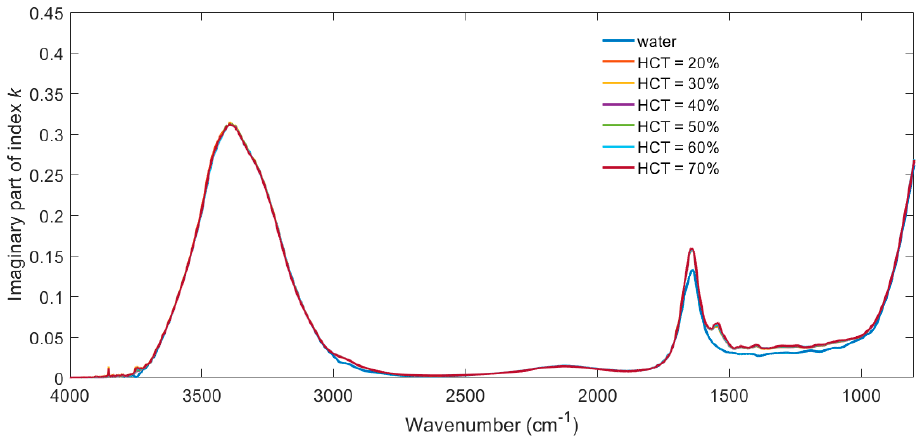
Figure 3. Imaginary part of refractive index spectra k( λ ) for water and whole blood with haematocrit in the range of 20–70%.